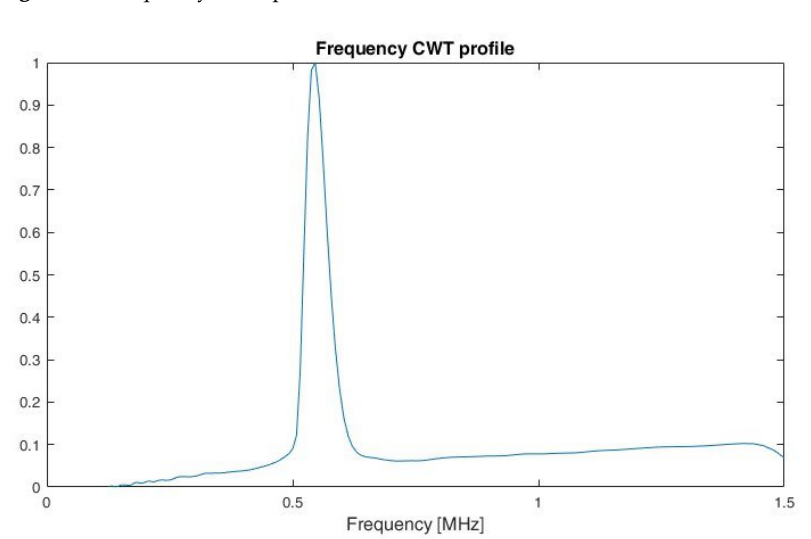
Figure 12. Frequency CWT profile for SFCW.